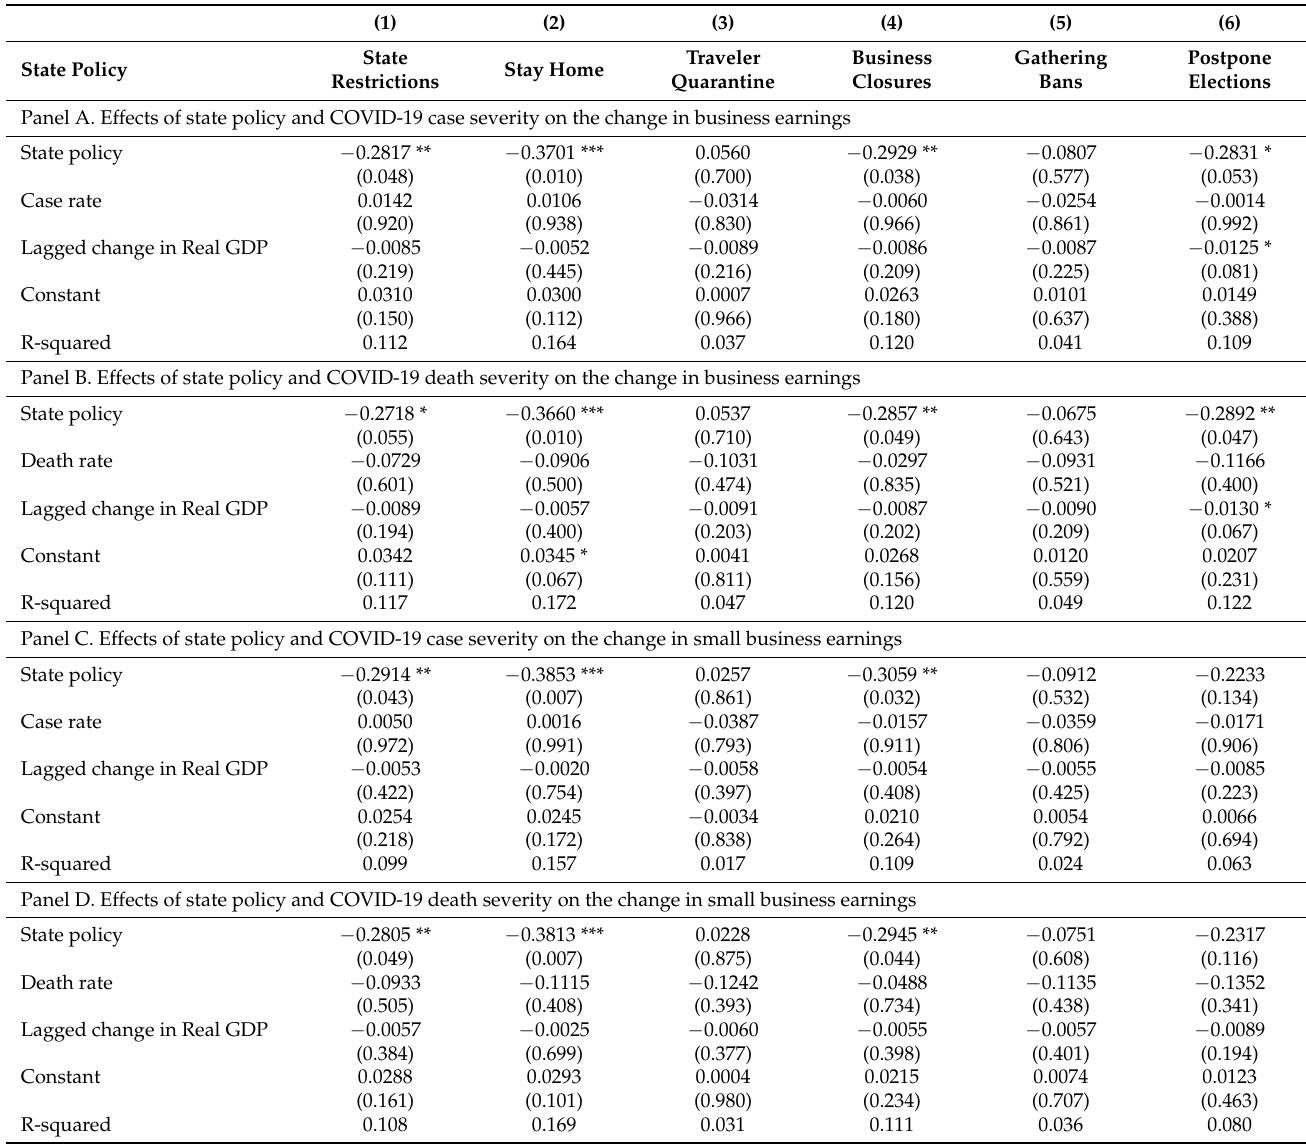
Table 8. Effects of state policies and COVID-19 severity on local business